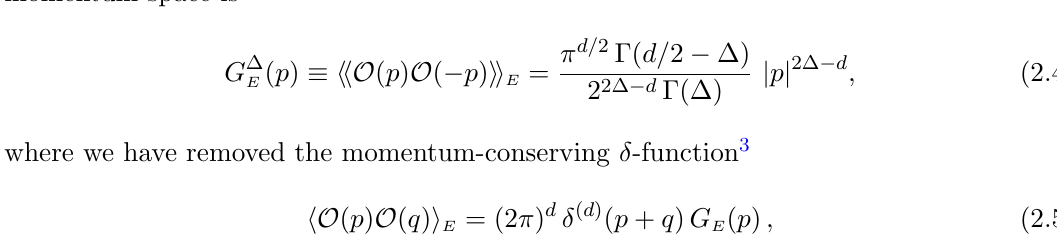
( x ) (0) and the contour on the left to hO O i